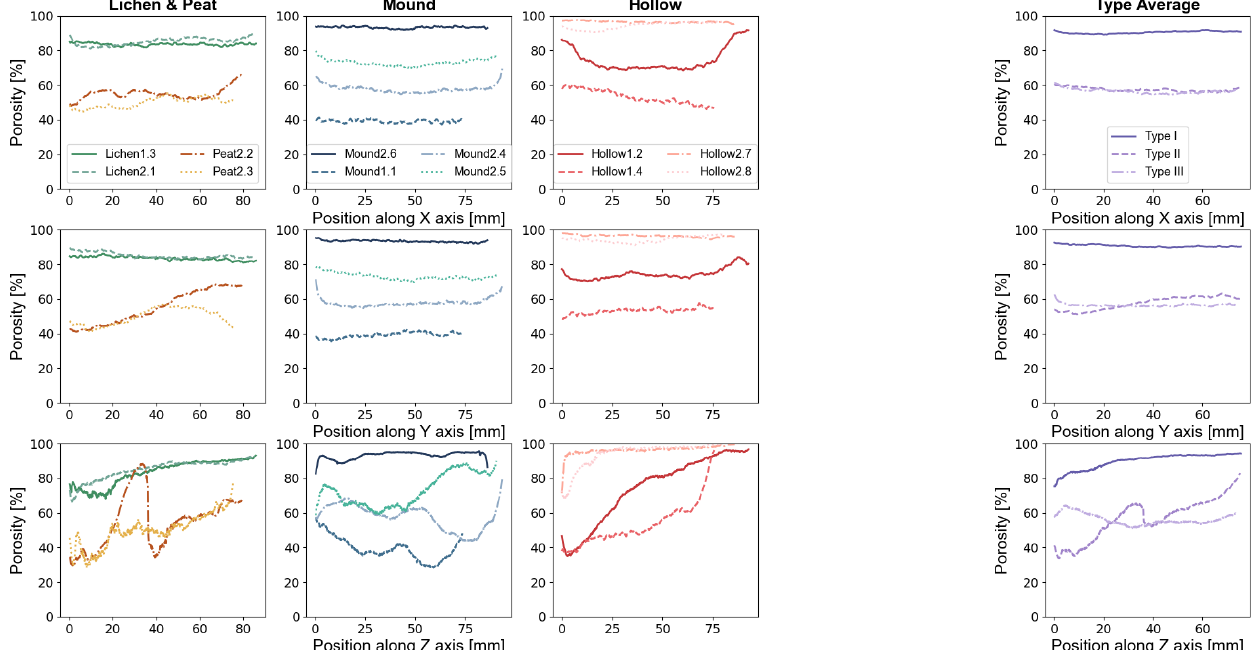
Figure 4. Planar porosity plot along the x , y and z axes for moss, lichen and peat samples. An averaged value is computed for each sample type, each color nuance representing each type. Type I: stable high-porosity profile samples, excluding border effects. Type II: low basal porosity, linearly increasing to the top of the sample. Type III: no specific trend observed in vertical porosity.